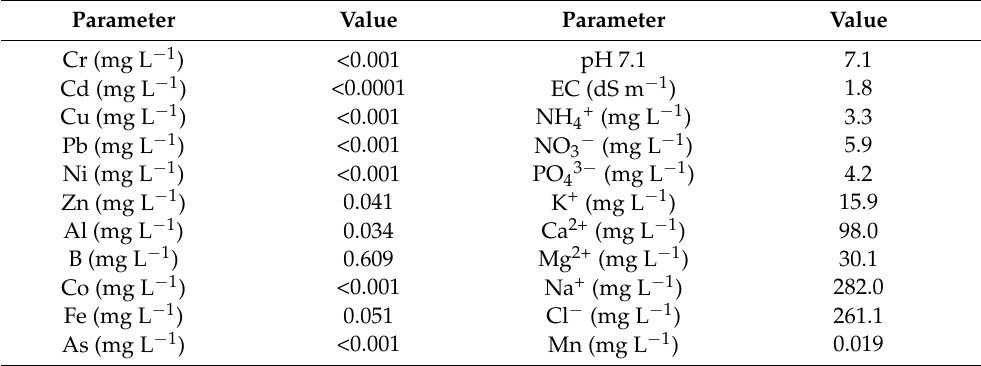
Table 2. Analysis of treated wastewater (TWW) used to irrigate the crops in the current study.